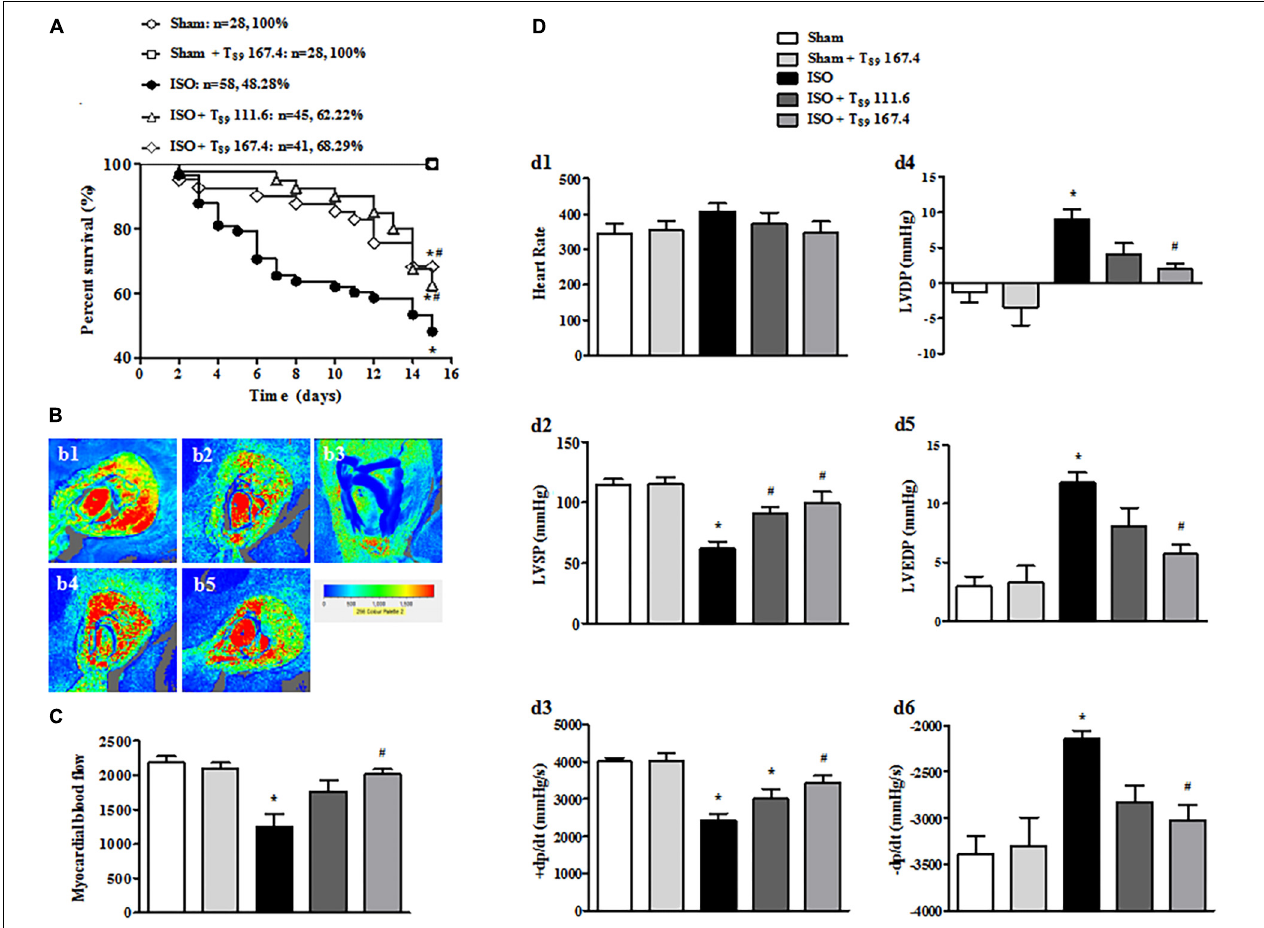
FIGURE 1 | Effects of T 89 on survival rate, MBF, and heart function in rats exposed to ISO. (A) The survival curve of each group. (B) Representative color images of MBF in different groups acquired by Laser-Doppler Perfusion Imager. b1: Sham; b2: Sham + T 89 167.4; b3: ISO; b4: ISO + T 89 111.6; b5: ISO + T 89 167.4. (C) Quantitative evaluation of MBF, n = 12. (D) Presented are the value of HR (d1), LVSP (d2), +dp/dt max (d3), LVDP (d4), LVEDP (d5), and -dp/dt max (d6) in various groups, n = 6. Data are presented as mean ± SE. * P < 0.05 vs. Sham group, # P < 0.05 vs. ISO